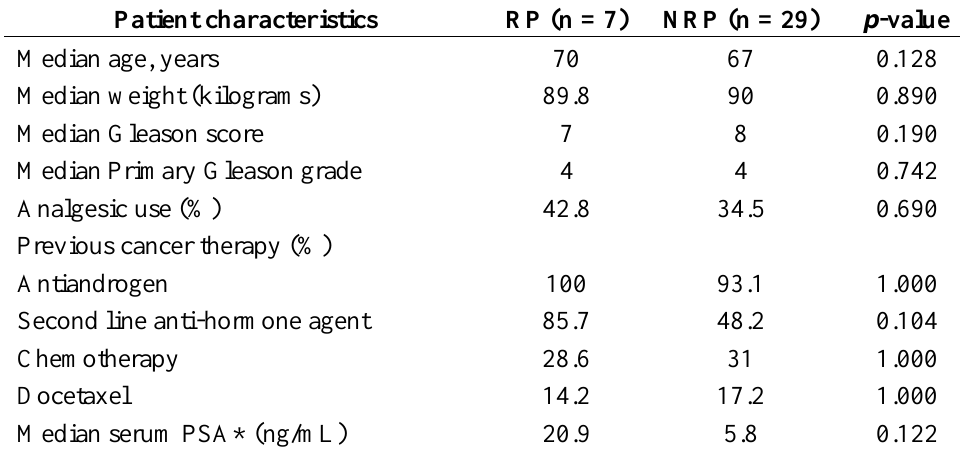
Table 3. Univariate analysis of risk